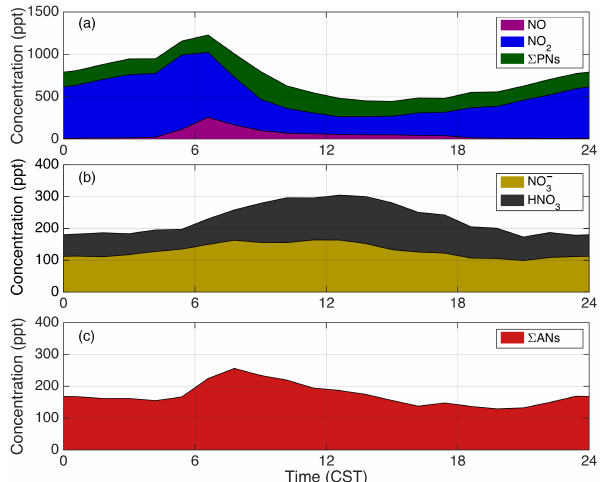
Figure 2. Diurnal cycle of measured reactive nitrogen species dur- ing SOAS. Reactive nitrogen species are classified as likely compo- nents of NO SL (a) , likely components of NO LL (b) or unknown (c) . The classification into NO SL and NO LL is based on typical sum- mertime afternoon lifetimes. The measurement of HNO 3 represents nitric acid in the gas phase, while the measurement of NO − resents inorganic nitrate in the particle phase. The measurement of (cid:54) ANs includes alkyl and multifunctional nitrates in both the gas and particle phase.